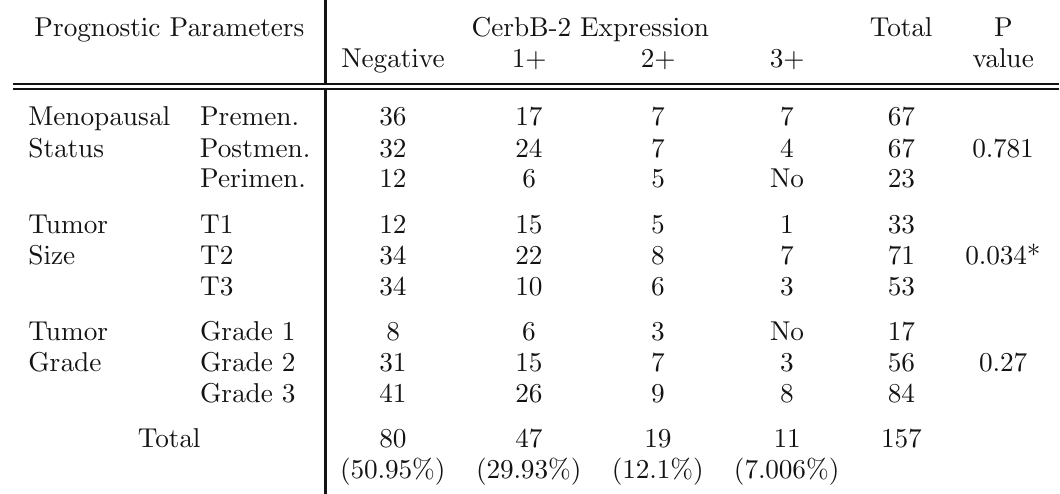
Table 2 Menopausal status, tumor localization, size and grade of patients arranged due to CerbB–2 expressions.